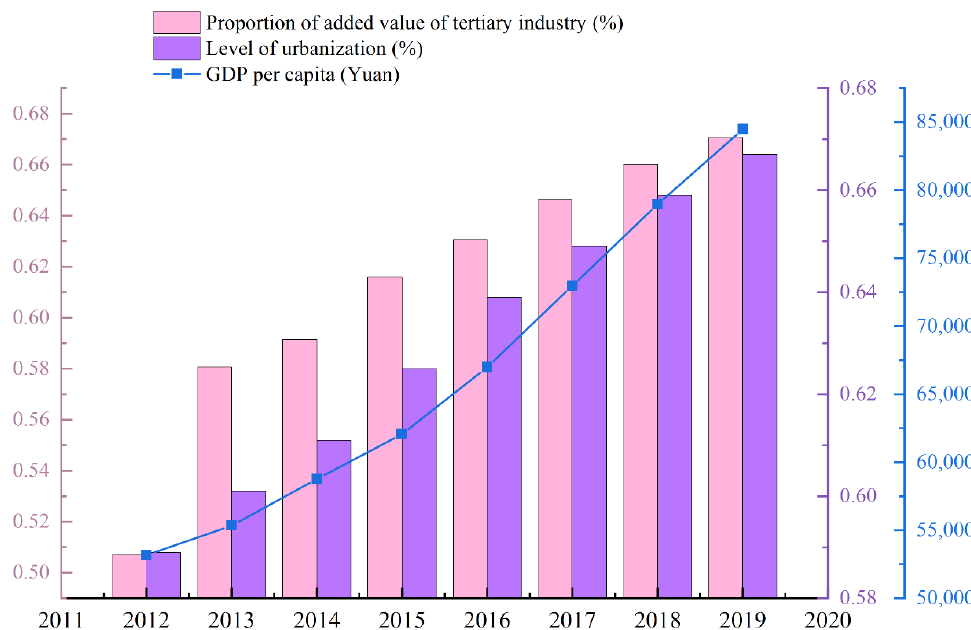
Figure 4. Indicators affecting the carbon peak period in Hebei Province.